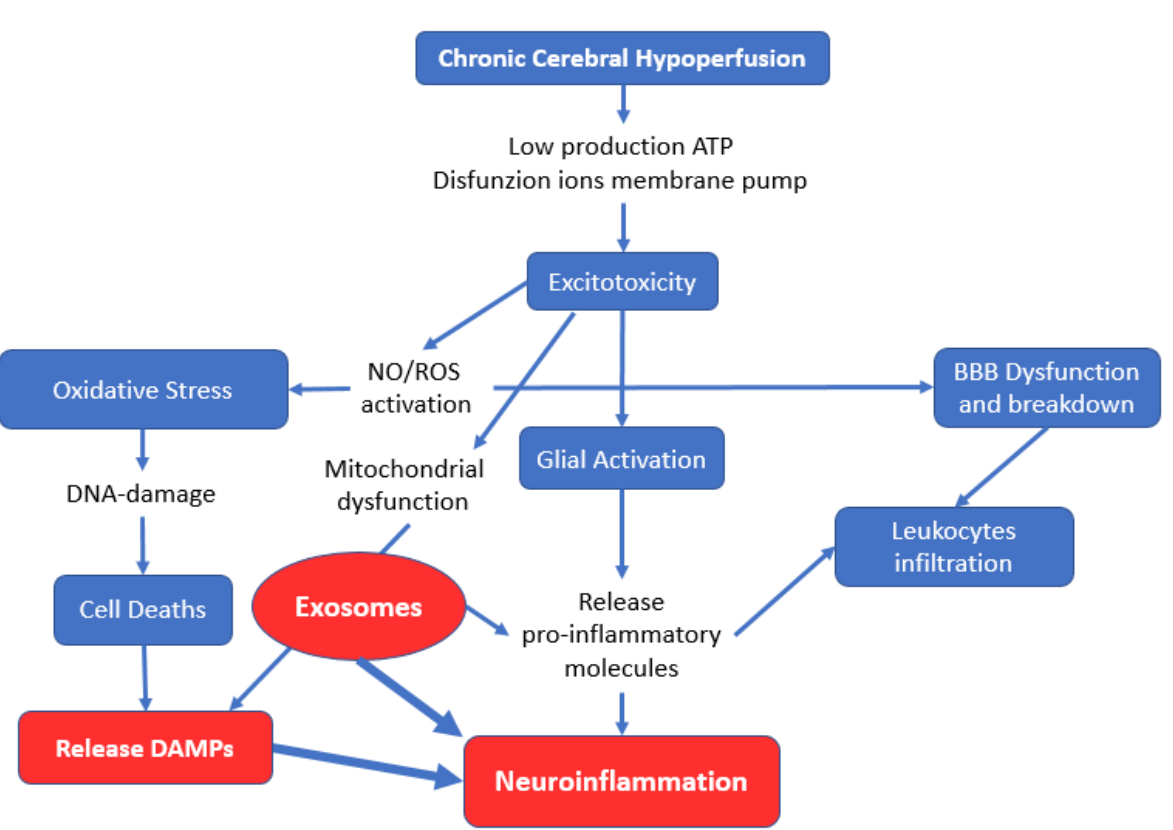
Figure 1. The potential physiopathological pathways of neuroinflammation involved in chronic cerebral hypoperfusion, which results in neuronal death and decreased production of angiogenesis regulators, leading to neurovascular unit uncoupling. These circumstances combine to induce chronic cerebral hypoperfusion, which lowers the amount of glucose and oxygen delivered to the brain, resulting in reduced ATP synthesis, bioenergetic impairment, and a number of pathogenic molecular and cellular processes. The function of the ATP-dependent transporters, such as the Na+/K+ ATPase, is initially affected, causing an ionic imbalance (i.e., Na+ and Ca2+ influx, and K+ efflux) across the plasma membrane, which causes anoxic depolarization within neurons and excitotoxicity in the form oxidative stress by activating a range of calcium-dependent ROS producing mechanisms in the mitochondria and cytoplasm. Thus, the DAMPs released by stressed or wounded cells bind to pattern recognition receptors (PRRs) to trigger an inflammatory response initiating the cascade process of neuroinflammation. Glial activation, BBB disruption, cell death, and demyelination are outcomes of these molecular pathways acting in concert with various cell types. White matter lesions, microinfarcts, and hippocampal atrophy are all examples of structural damage that is brought on by the these pathogenic processes. Each of the above anatomical alterations disrupts the functional connections and neural network, which eventually results in cognitive